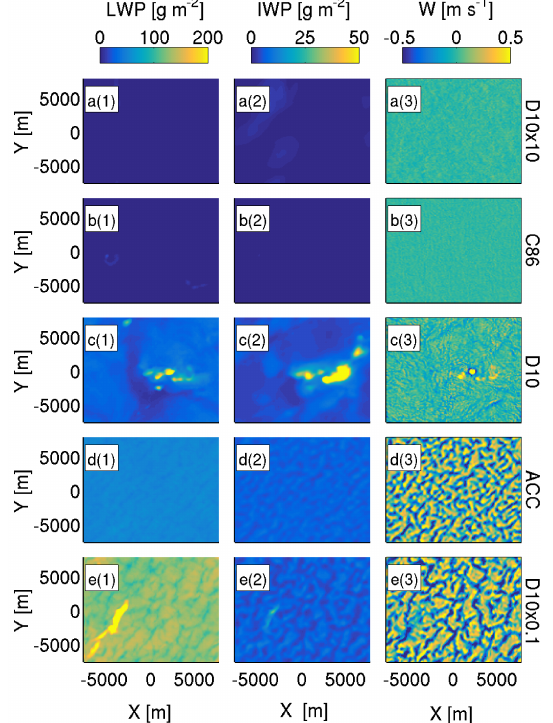
Figure 11. LWP (a1–e1) , IWP (a2–e2) , and vertical velocity (W, a3–e3 ) at approximately 1500m for each simulation in the ocean case. Planar X − Y slices are shown at 21h. Note changing colour bar at the top of each column, which corresponds to data in that column only.